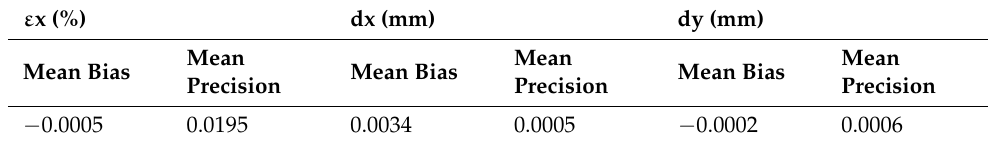
Table 4. Mean bias and precision for 3D DIC system calculated from static